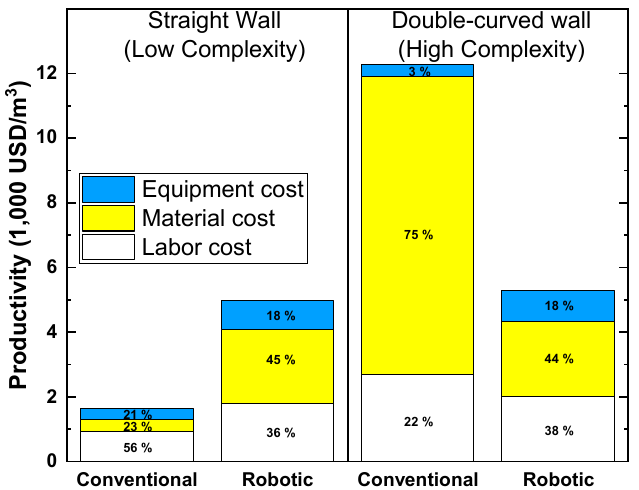
Figure 8. Breakdown of cost components in different construction scenarios. Reprinted with permission from ref. [9]. Copyright 2018 Copyright Elsevier Ltd.